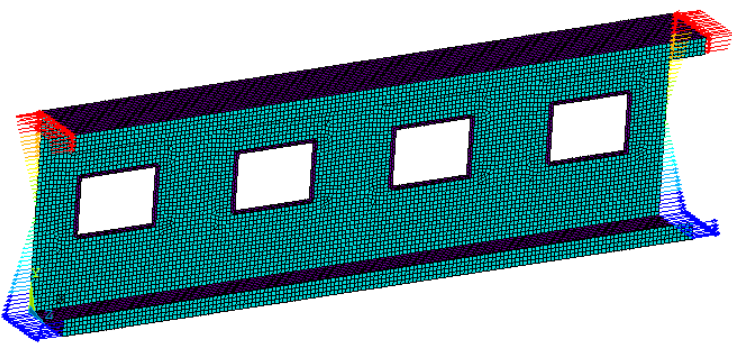
Figure 7. Finite element mesh of a perforated beam and the force boundary condition.